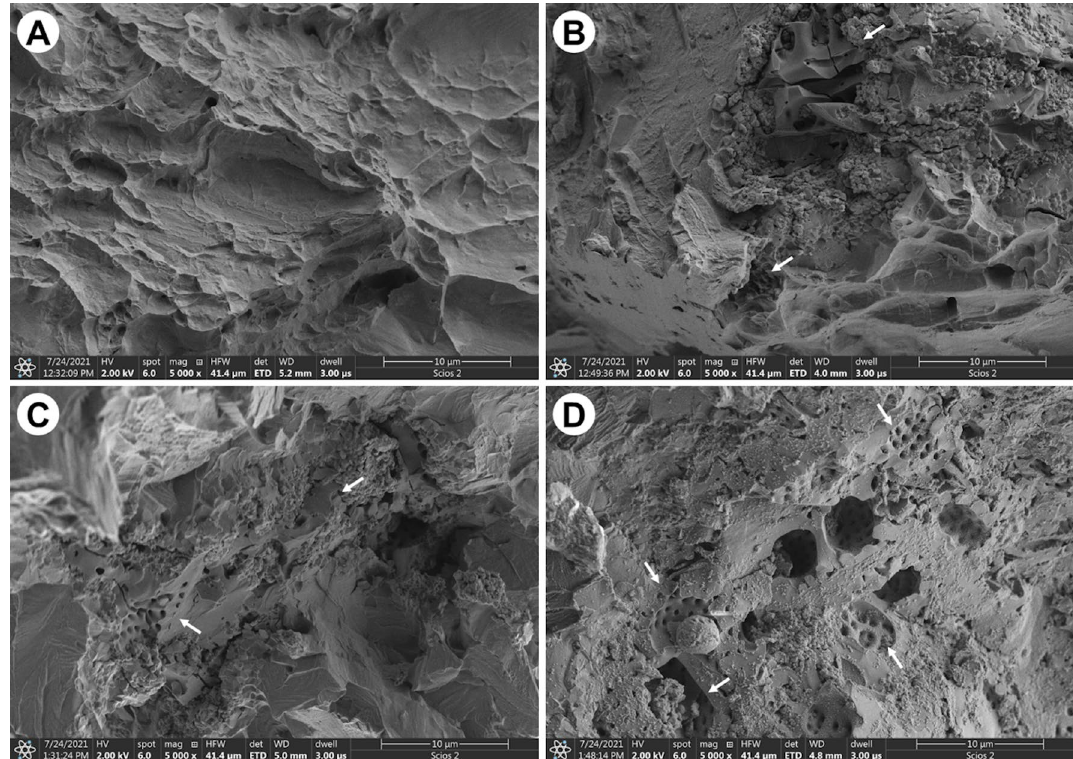
Figure 3. SEM images of fracture surfaces in the composite specimens: ( a ) Ti6Al4V alloy, ( b ) Ti6Al4V/1%DE, ( c ) Ti6Al4V/5% DE, ( d ) Ti6Al4V/10% DE; white arrows—in‑prints of diatom frustules in the metallic matrix.